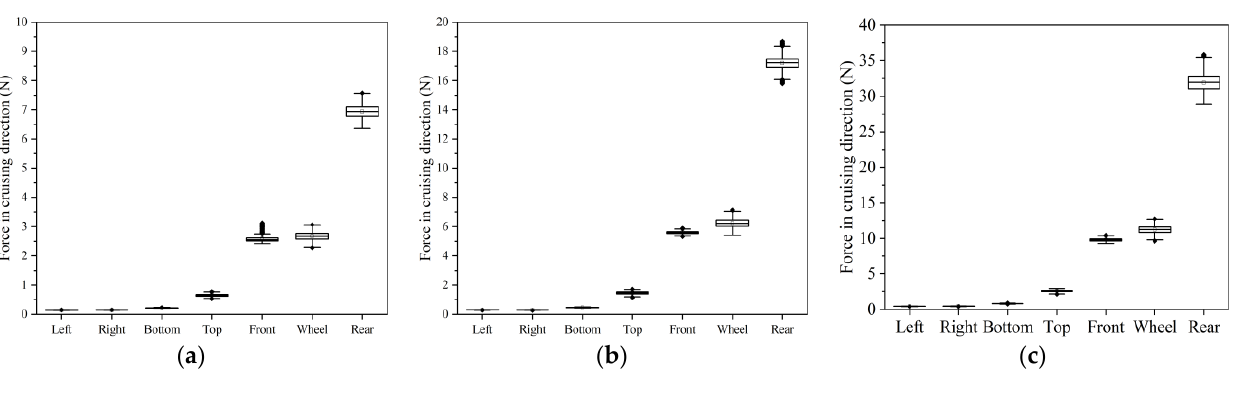
Figure 5. Total drag force fluctuation over time.